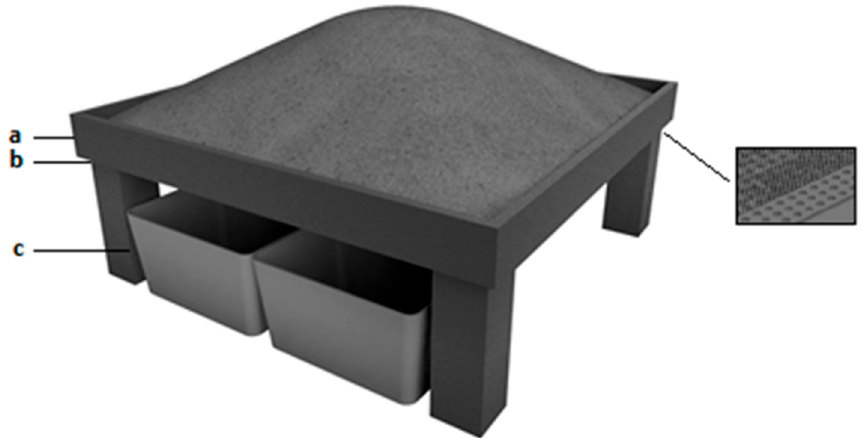
Figure 1. Laboratory stand used for MSWI bottom ash natural weathering experiments: (a) Storage tank for MSWI bottom ash; (b) holes, covered with plastic mesh, for leachate draining; (c) leachate collection tank.